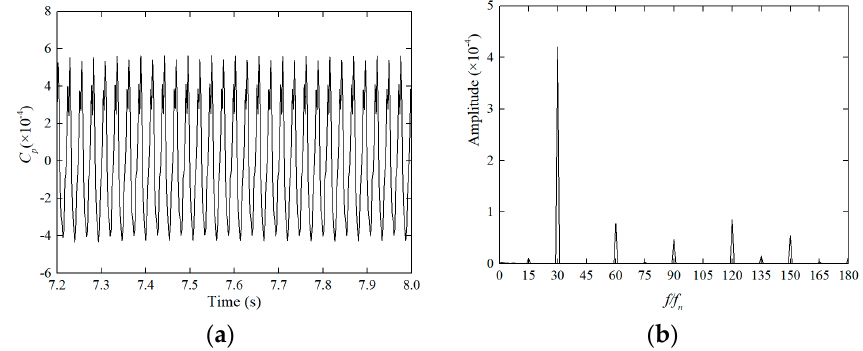
Figure 8. Time and frequency analysis of C p at the measuring point F04. ( a ) Time domain graph, ( b ) frequency domain graph.